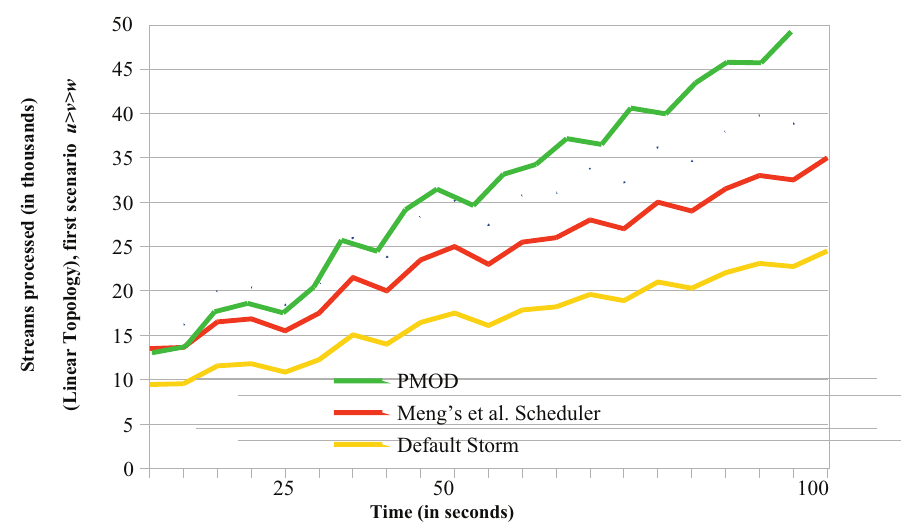
Figure 6. Throughput comparisons with a linear topology for the first scenario: ( u > v > w ) .